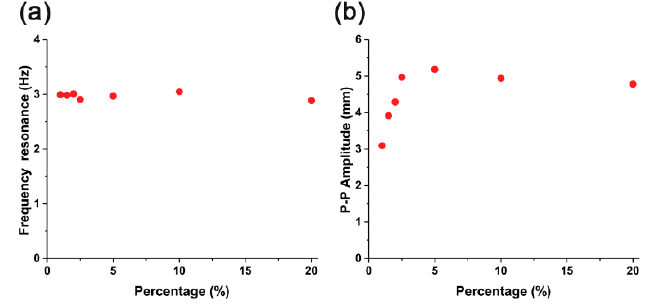
Figure 6. ( a ) Frequency resonance and ( b ) peak-to-peak amplitude of Fe 3 O 4 -silicone composite actuators.